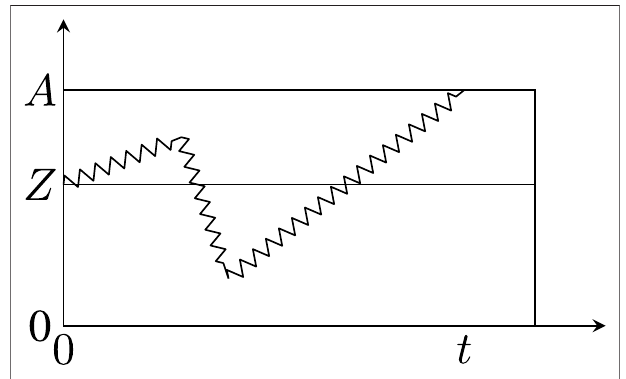
FIGURE 1 | Brownian motion, B ( t ) , starting at Z and with absorbing boundaries at A (top) and 0